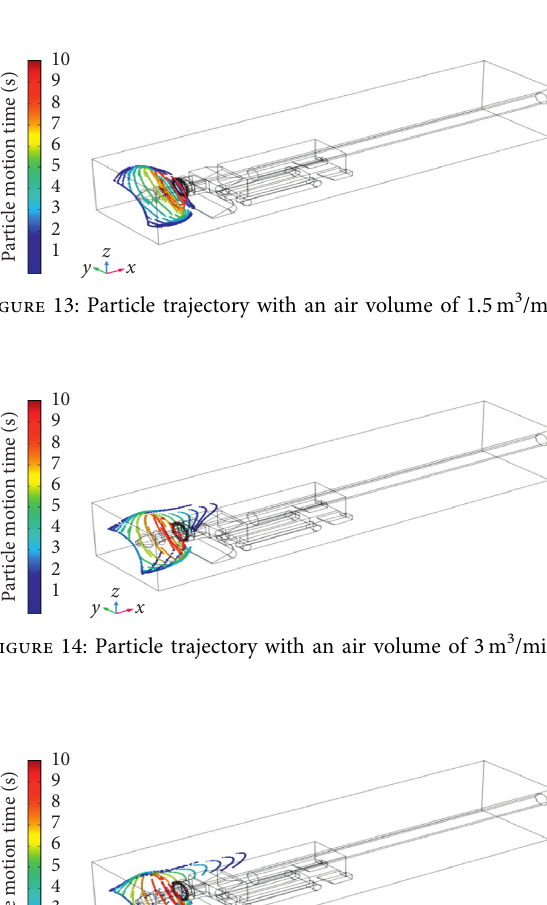
Figure 12: Physical model of a new type of external pneumatic vortex fog curtain dust removal device integrated dust control system in fully mechanized excavation face.